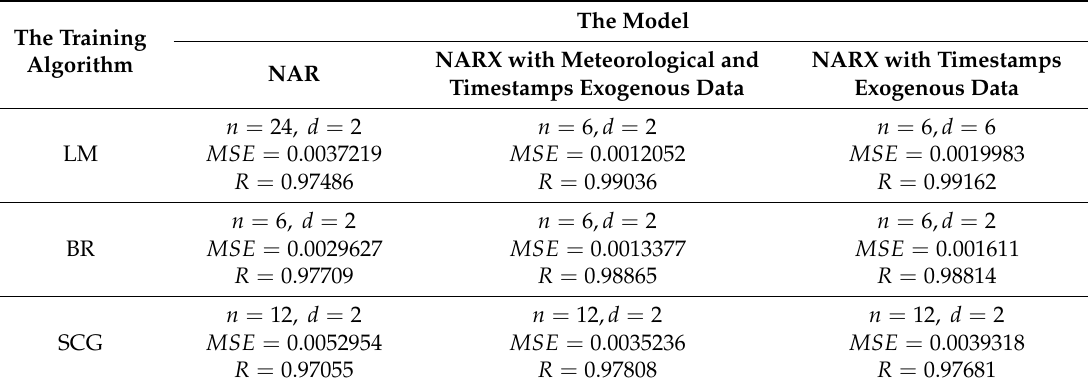
Table 7. The worst mix ( n , d ) and the corresponding performance